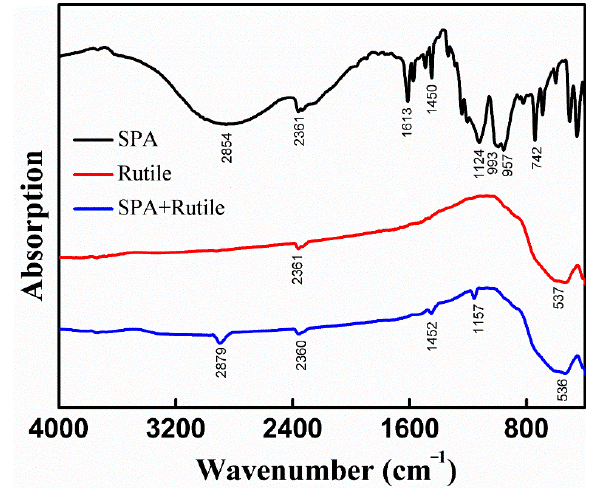
Figure 5. Infrared spectrum of SPA, rutile and rutile with SPA adsorbing treaded (at pH = 2.3).